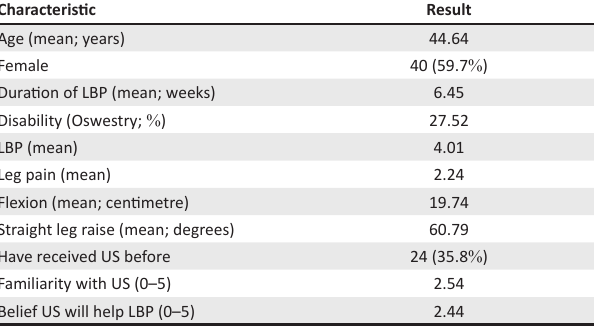
TABLE 1: Demographic information. Characteristic Result